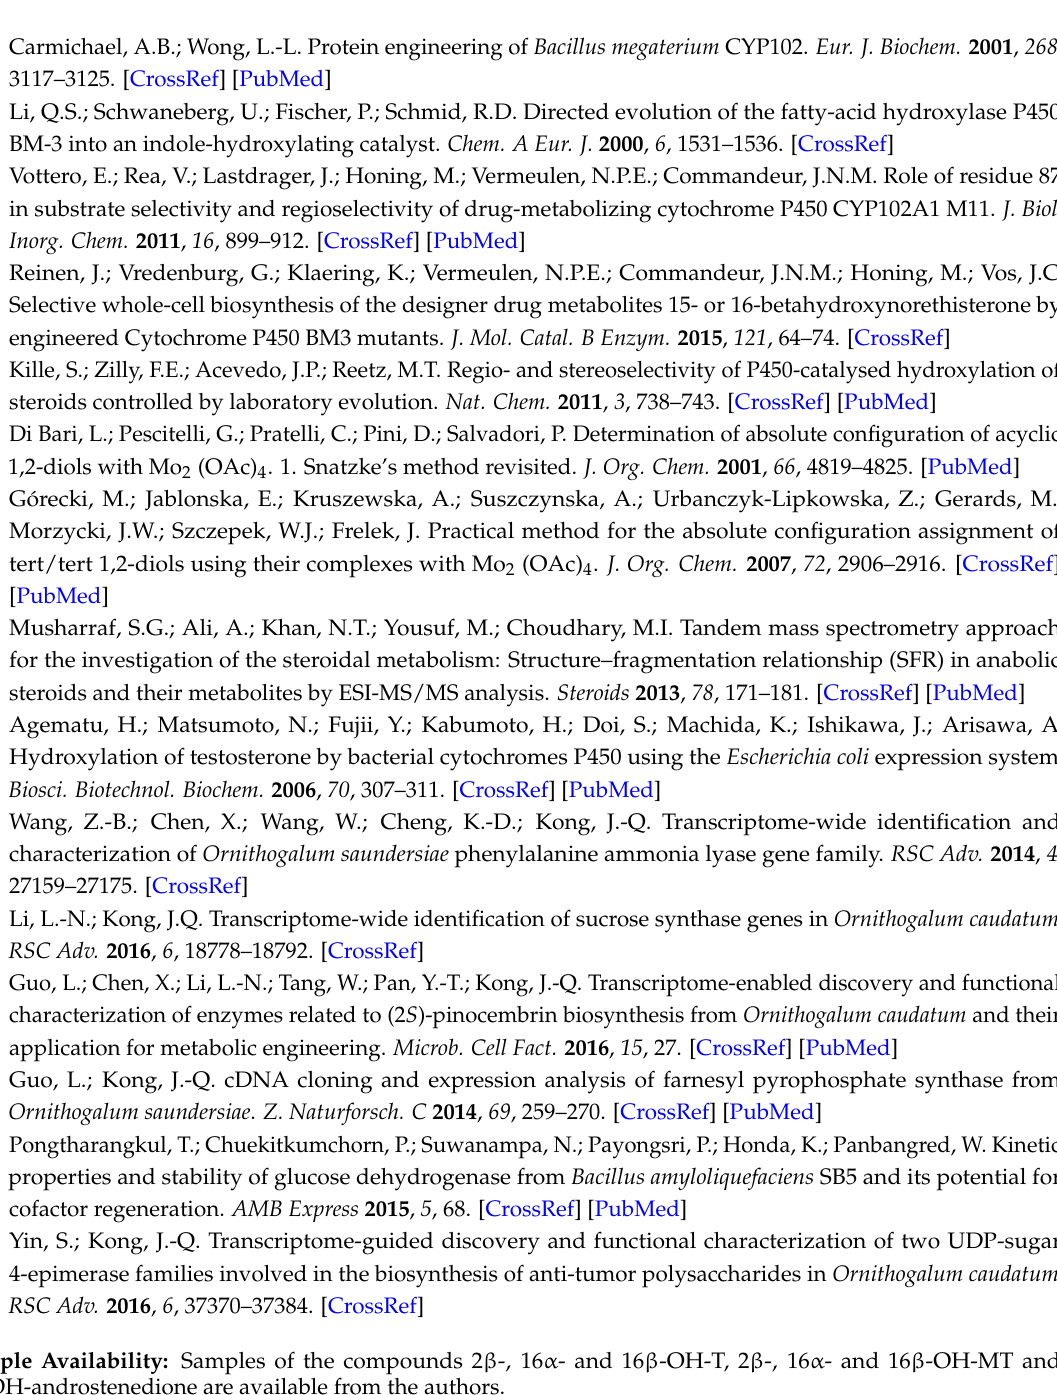
Sample Availability: Samples of the compounds 2 β -, 16 α - and 16 β -OH-T, 2 β -, 16 α - and 16 β -OH-MT